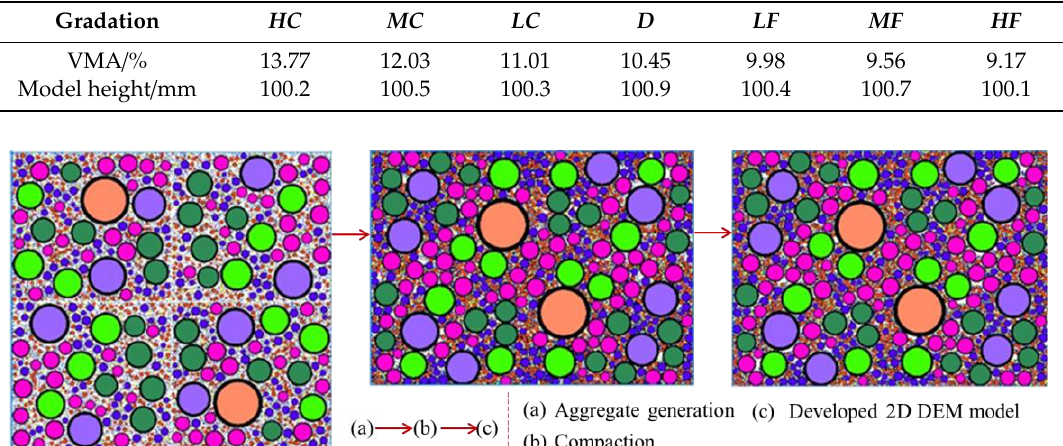
Figure 1. Development of 2D DEM Model.